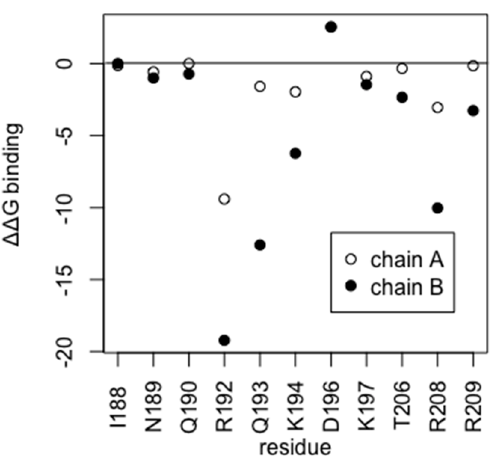
Figure 6. ∆∆ G binding energy (kcal/mol) plot obtained from alanine Figure 6. ΔΔ G binding energy (kcal/mol) plot obtained from alanine scanning.